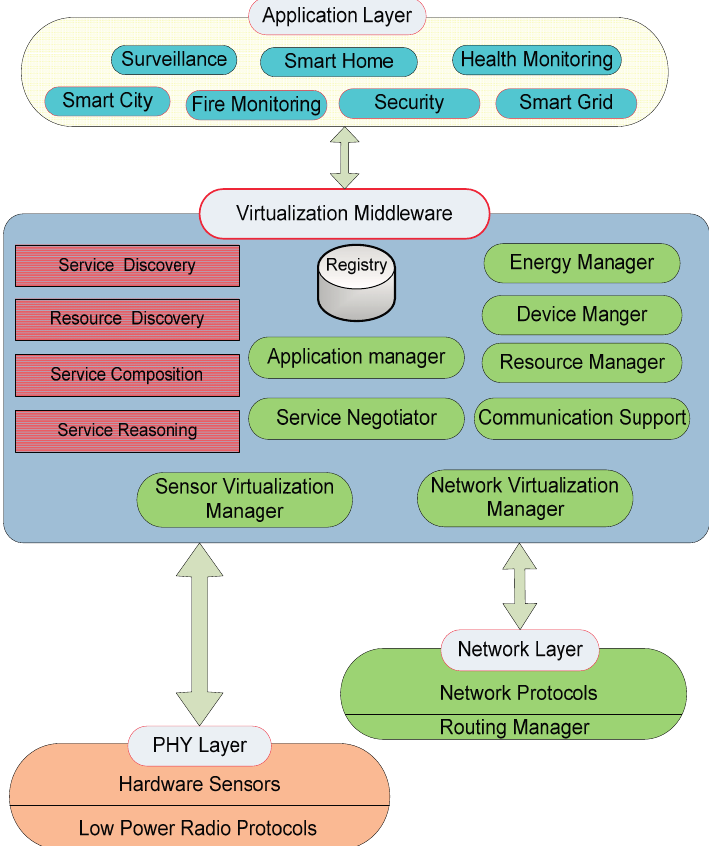
Figure 1. General model for WSN virtualization